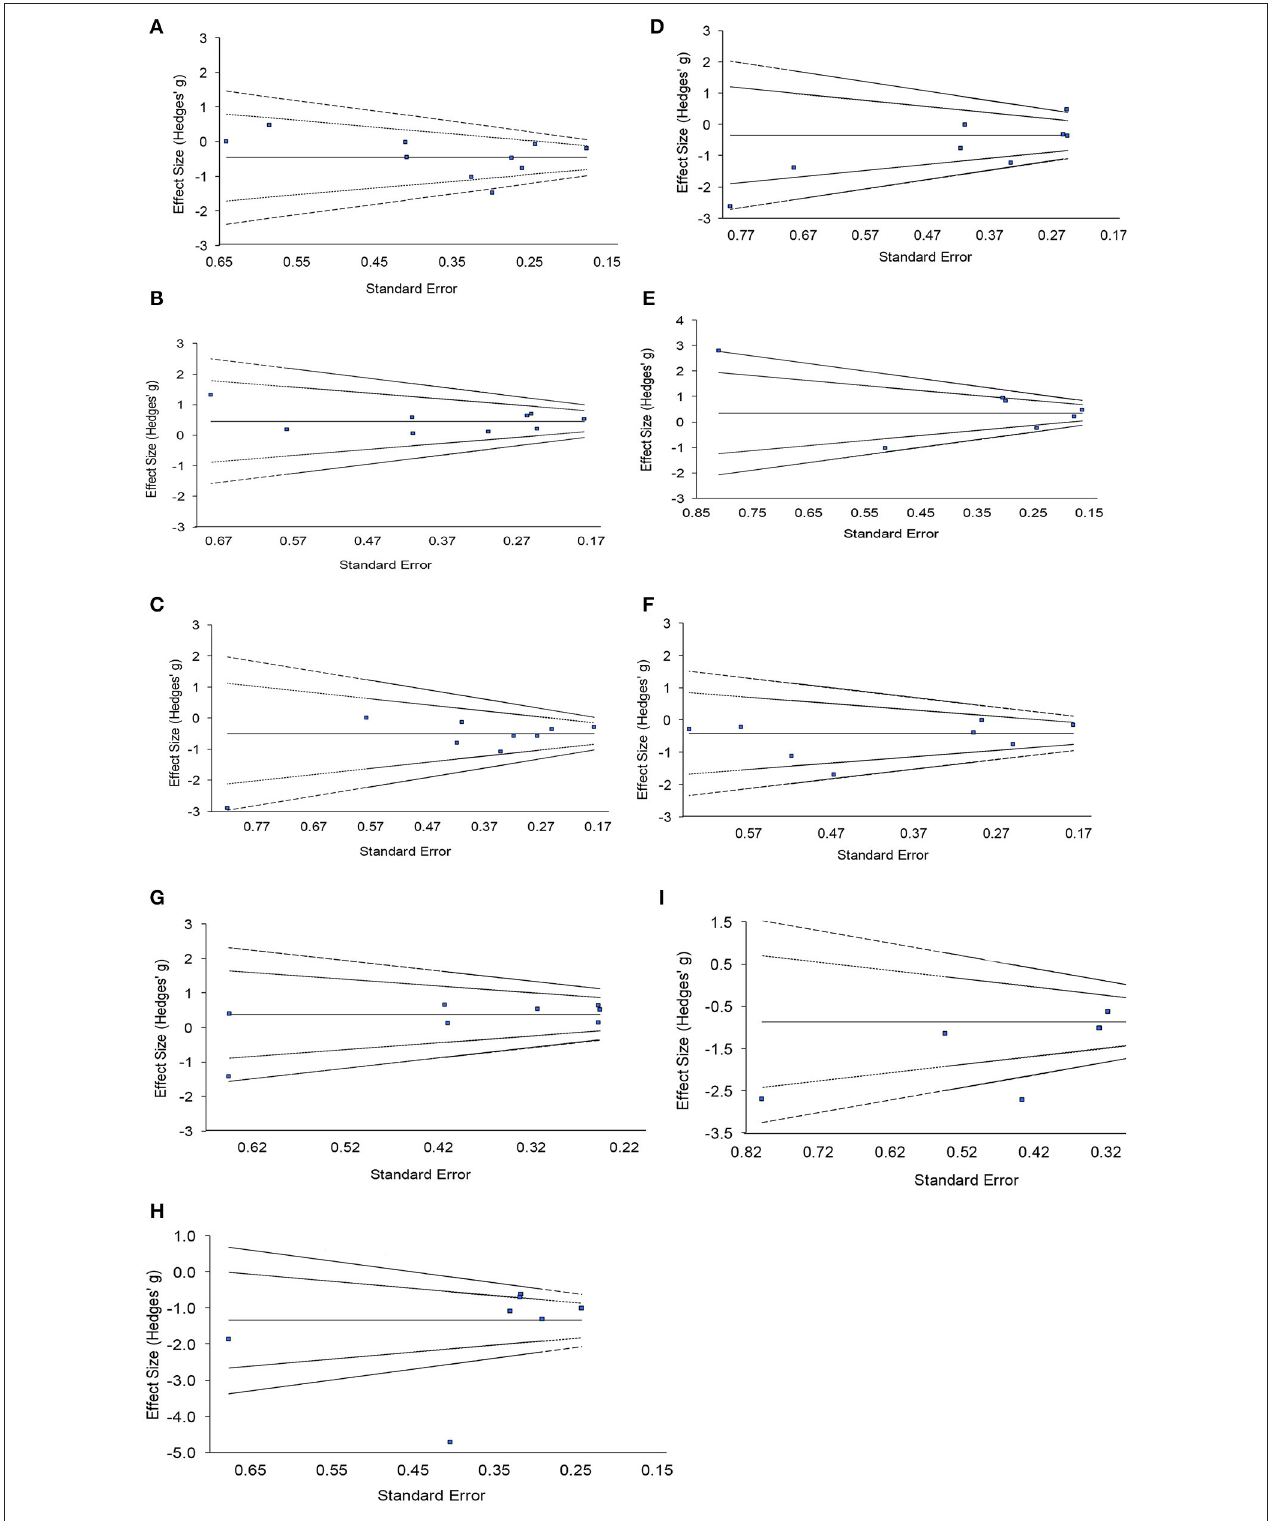
FIGURE 3 | Funnel plots with pseudo 95 and 99.7% confidence intervals assessing publication bias of included studies for nine actigraphy measures. (A) Interdaily stability, (B) intradaily variability, (C) relative amplitude, (D) activity of most active 10h, (E) total sleep time, (F) sleep efficiency, (G) activity of least active 5h, (H) daytime activity, (I)